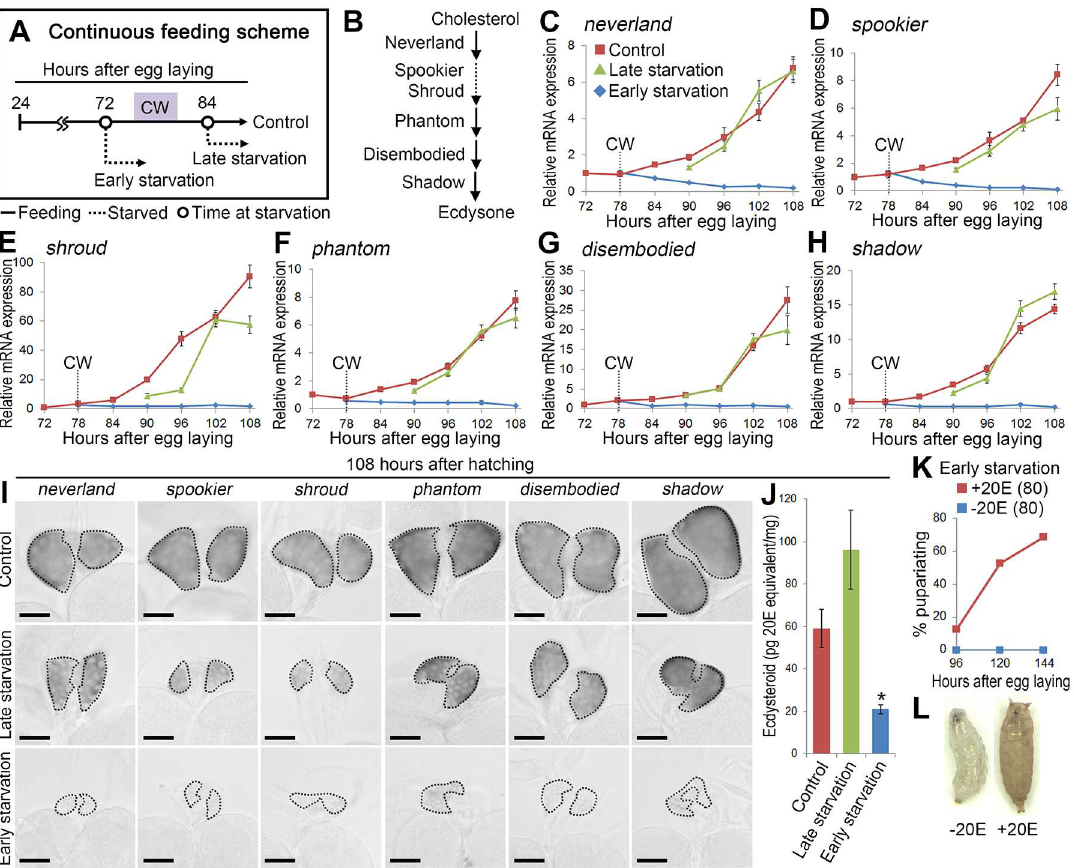
Fig 1. CW attainment is coupled with activation of ecdysone biosynthesis. (A) Schematic diagram of the continuous feedingscheme. Wild-type Oregon R larvaewere reared on standard Drosophila medium (solid line) either continuously (control) or starved (dashedlines) from indicatedtime points. The CW checkpoint (78 hAEL) is indicatedby a shaded box. (B) Schematic diagram of ecdysonebiosyntheticpathway. (C–H) Starvation before CW attainment impairs increase in expression of ecdysonebiosyntheticgenes. Expression of ecdysone biosyntheticgenesin control, late starved and early starved larvae was measuredusing qPCR. The CW checkpointin control is indicatedby dashedlines. Average values of five independent data sets are shown with standard errors. (I) Starvation before CW attainment causes decrease in expressionof ecdysone biosyntheticgenesin the PG. Whole-mount in situ hybridization was performed using antisenseprobes in control and starved larvae (late and early starvation)at 108 hAEL. The PGs are outlined by dashedlines. Scale bars, 50 μ m. (J) Starvation before CW attainment causes decreasein ecdysteroidlevel. Whole-body ecdysteroidlevels in control, late starved and early starved larvae at 108 hAEL were measured using ELISA. Average values of five independentdata sets are shown with standard errors. Statistical significancewas calculatedusing ANOVA with Tukey’s post hoc test ( * P < 0.05). (K) 20E feedingrescues developmental arrest in early starved larvae. Larvaewere starved on wet filter paper with or without 1 μ g/ml 20E from 72 hAEL. Percentagesof pupariatedanimalsare shown at indicatedstages. Numbers of animalstested are in parentheses. (L) Control starved larva (left) and pupariatedanimalby 20E